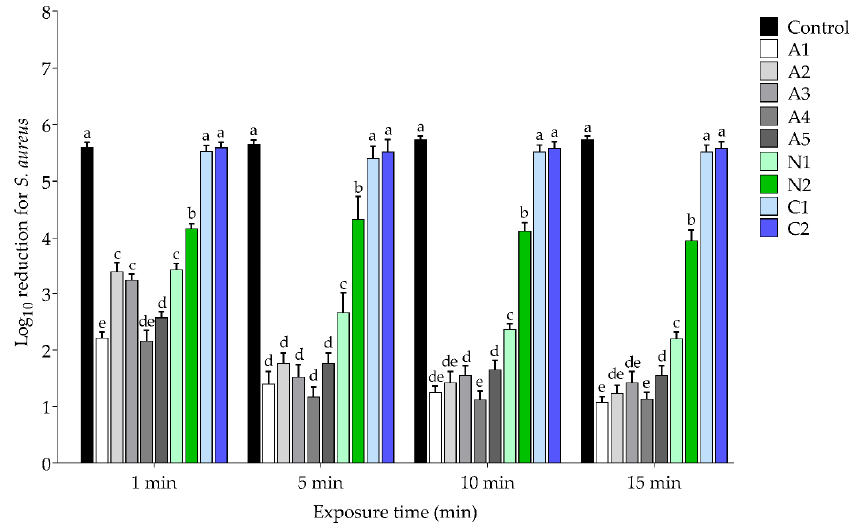
Figure 4. Log 10 reduction of S. aureus at different exposure times to a mixture of CHG and selected lubricating gels. Data represent the mean ± SD of three independent experiments, and different letters (a–e) indicate a significant difference ( p < 0.05).